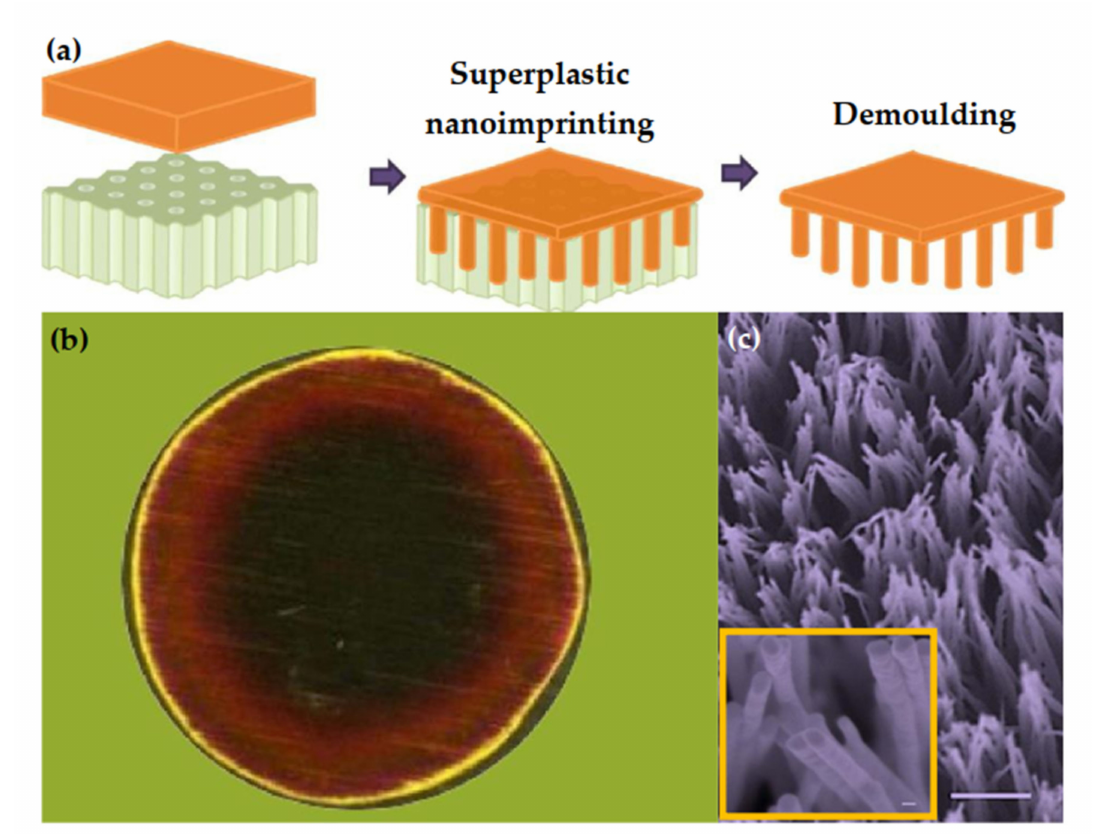
Figure 6. Flow chart of superplastic nano die casting technology: ( a ) Schematic of the SPNI process. ( b ) Optical micrograph of an as-thermoplastic-formed Au/Al 2 O 3 template combination, which was prepared by SPNI under an applied force of 5 kN and holding for ∼ 60 min (scale bar, 1 mm). ( c ) microstructure of the surface in ( b ) observed by an electron microscope. The uniform rust-red color of the sample suggests that Au nanowire arrays have been replicated, which is verified by characterizing the sample under SEM after dissolving the Al 2 O 3 template in KOH solution ( c ) scale bar, 5 µ m. Inset figure (scale bar, 30 nm). Adapted from [106], under the terms of the Creative Commons CC BY